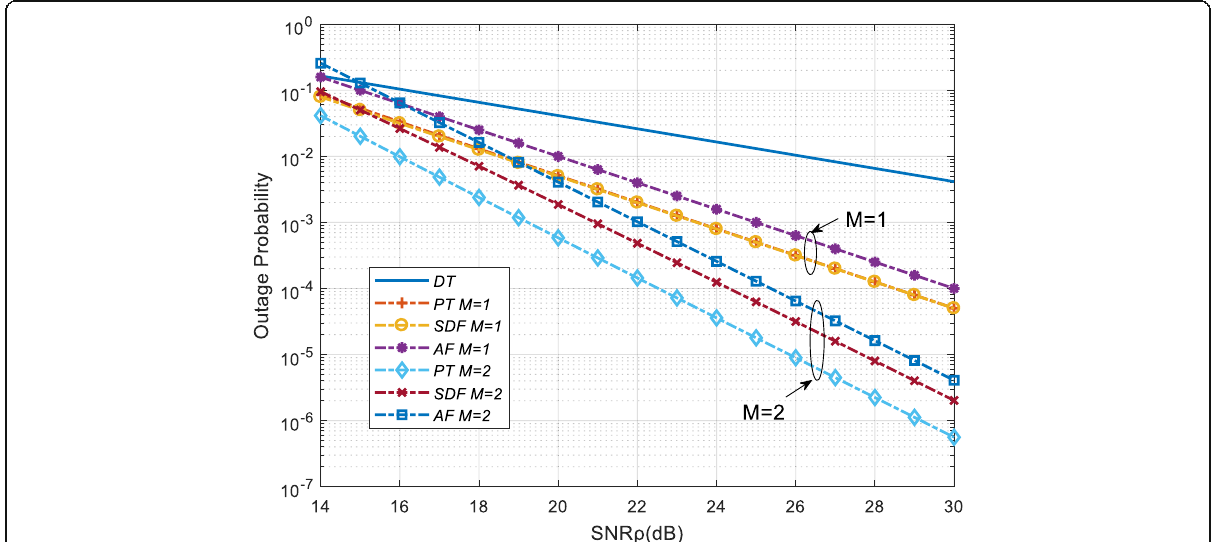
Fig. 5 Outage probability versus signal-to-noise ratio. The figure shows that the simulations on outage probability versus SNR of partial transmission (PT) and three conventional cooperative strategies, direction transmission (DT), selective decode-and-forward (SDF), and amplify-and- decode (AF) with the existence of direct link, on the situations with one-relaying system and two-relaying system. To simulate the unreliable relays, the simulation parameters are set as: the number of information bits is 100,000; the transmission rate of information is 0.5b/s/Hz; all the channel states from source to relays, relays to destination and source to destination are set the same, as 0.1. It can be seen in Fig. 5 that PT performs slightly worse than that of SDF before ρ = 24 dB when M = 1, because in the poor channels, the relay can hardly help the decoding at destination. After, PT gets the lower outage probability compared with SDF. Because as SNR increases, the relay can transmit more information block in PT, while SDF still has high probability failing to decode at the relay. When M = 2, PT gets better performance over the conventional strategies, because two relays can get double spatial diversity than that of the situation with M = 1. As SNR increases, the improvement of PT gets bigger. It is also noted that at low SNR, more relays cost more power and bandwidth, but they are unable to help the destination in such a low channel gain of S-R